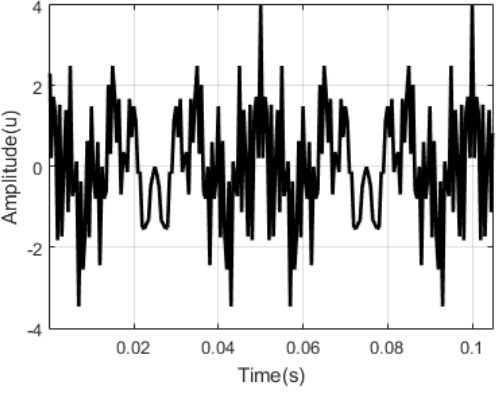
Figure 4. Harmonic signal without noise used to compare our method with that described in [5].